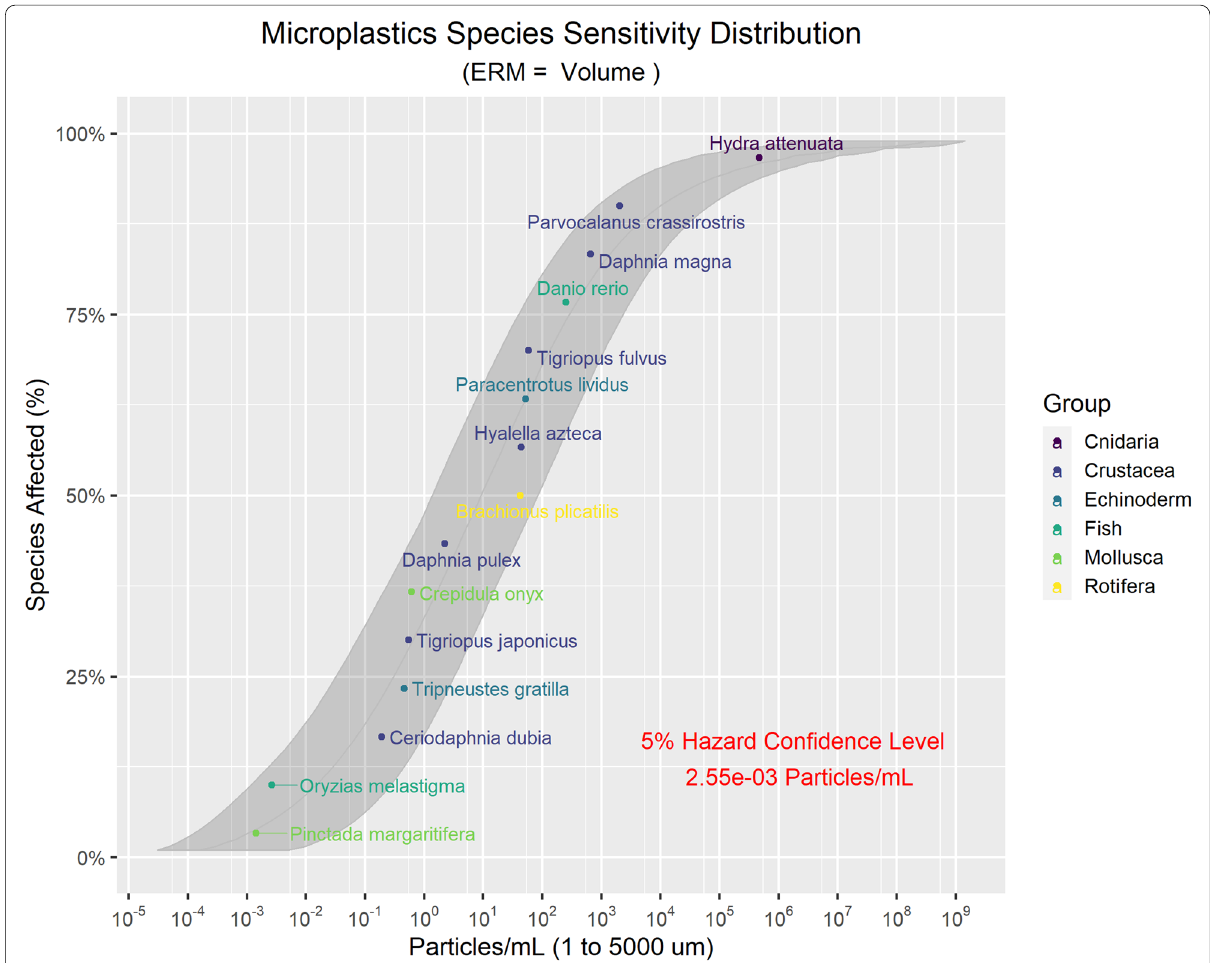
Fig. 3 Representative graphic generated using the Species Sensitivity Distribution tool. Data have been filtered to include “Particle Only” type data which passed “Red Criteria” during study screens. Data have also been aligned to the ecologically effect metric (ERM) of